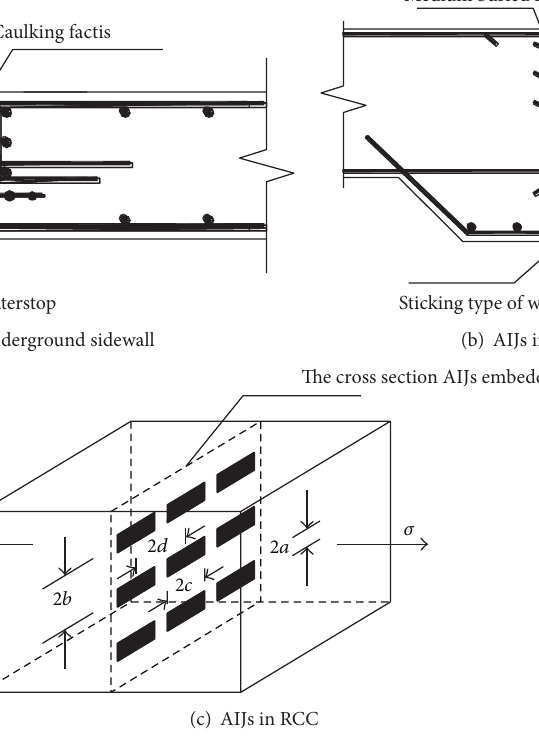
Figure 1: The detailed joint treatments of AIJs for different mass concrete.